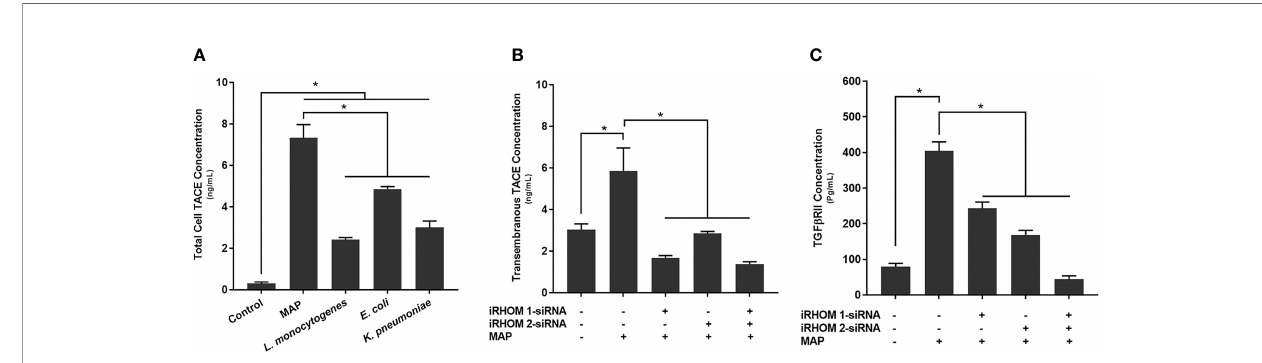
FIGURE 5 | The total concentration of TACE within bacteria infected cells (A) and the impact of TACE regression on the concentration of (B) transmembrane TACE levels and (C) TGF b RII shedding. The Kolmogorov – Smirnov normality test was used to test the normal distribution for all values and a two-way analysis of variance (ANOVA) was used to assess signi fi cance among experiments, which was followed by a Bonferroni correction test. All experiments were performed in triplicates. *Indicates P-value of less than 0.05.